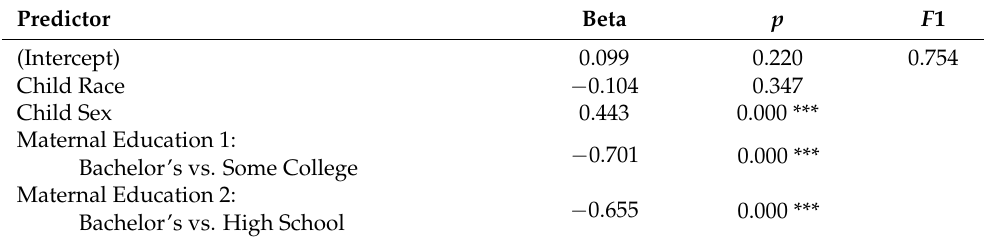
Table 6. H3: Child Characteristics